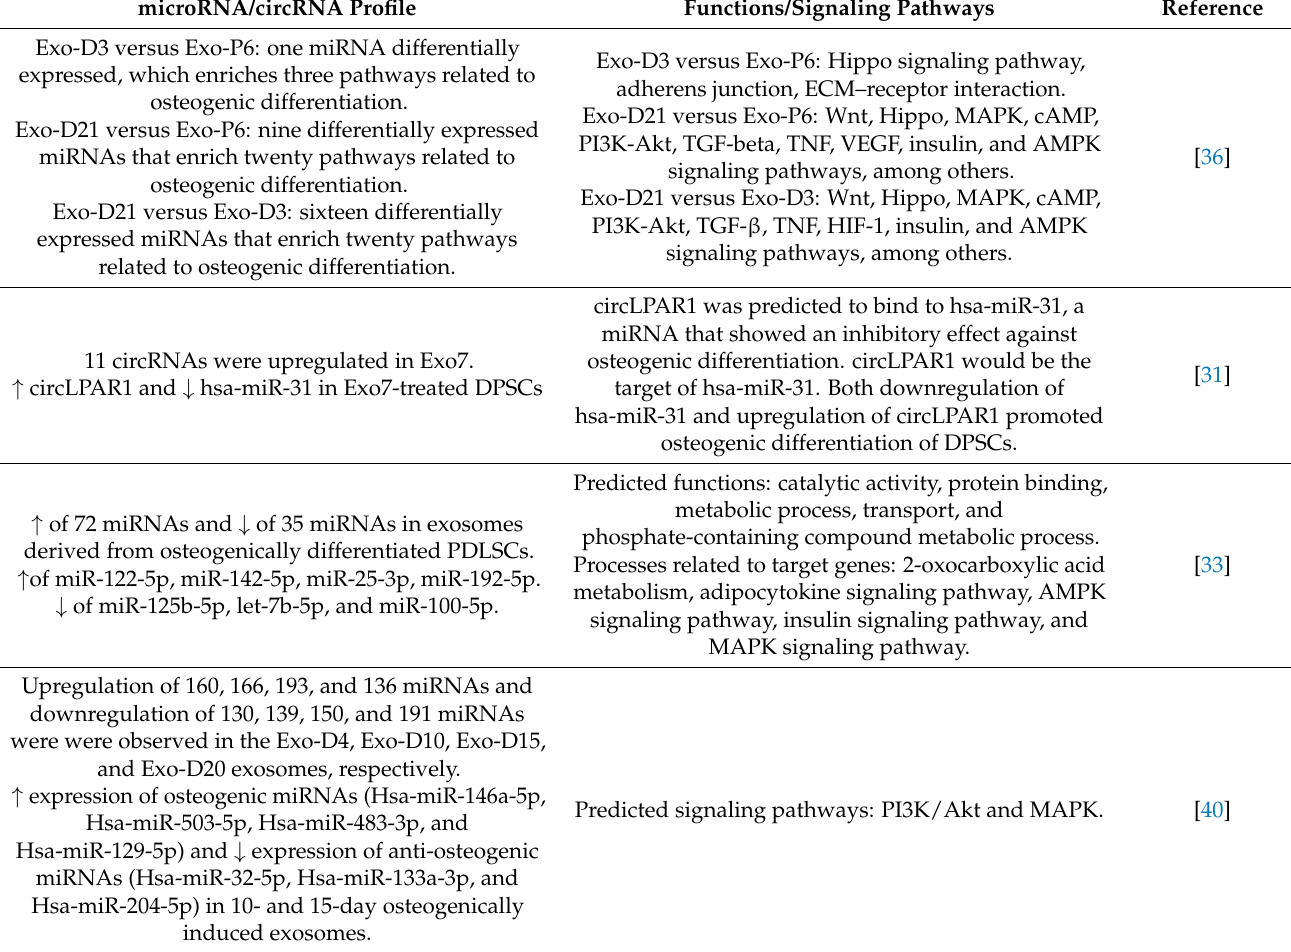
Table 5. Secondary outcomes related to microRNA/circRNA profile and signaling pathway/gene expression